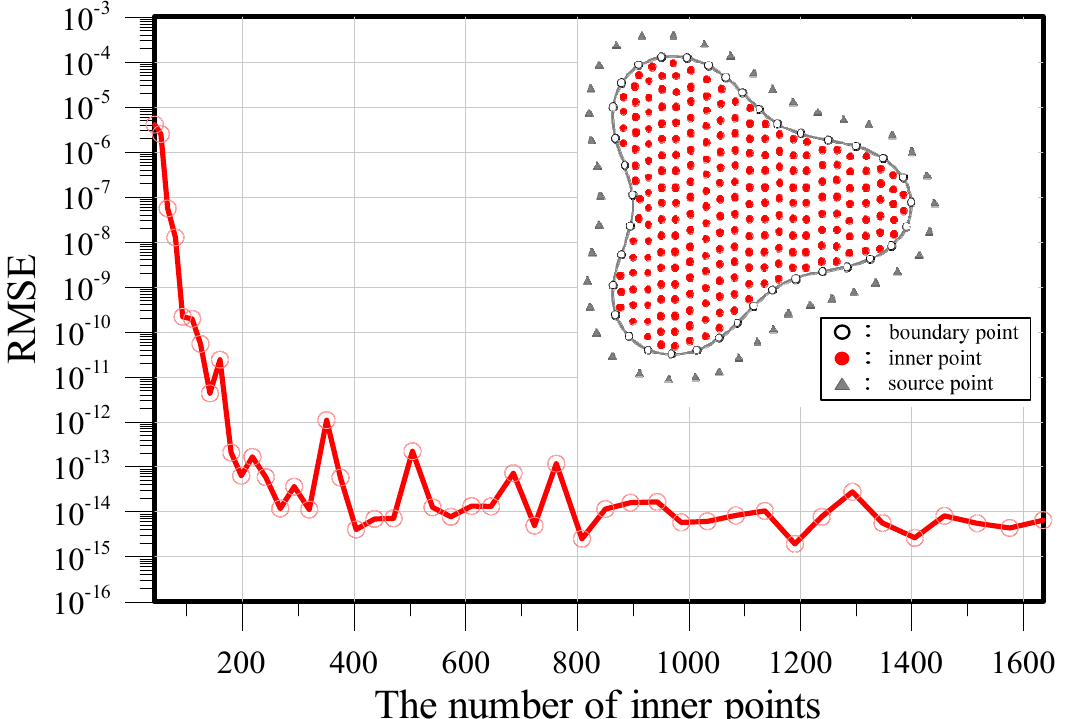
Figure 11. Number of inner points versus RMSE.